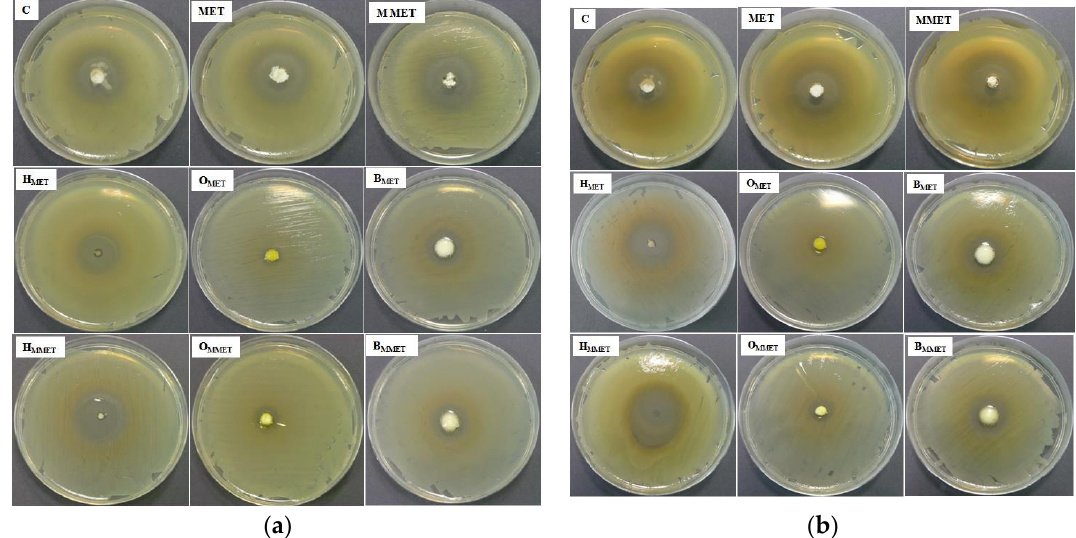
Figure 6. Antibacterial activity against S. aureus ( a ) and E. coli ( b ) of prepared hydrogels, oleogels, bigels containing MET (HMET, OMET, BMET), MMET (HMMET, OMMET, BMMET) and pure MET, MMET, commercially available product (C) as controls.